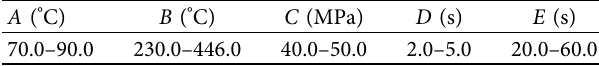
Table 4: Table of the test range of process parameters.